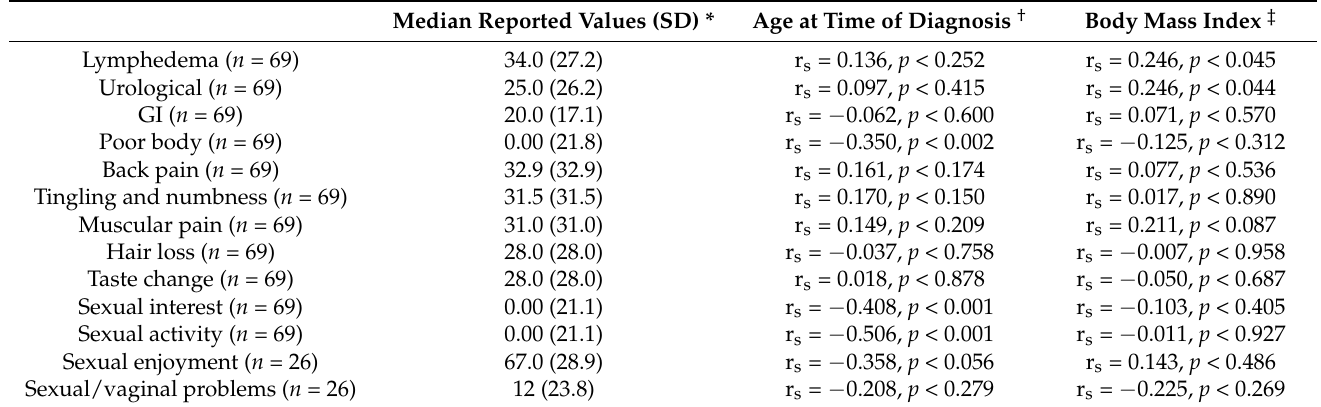
Table 1. Basic patient characteristics.